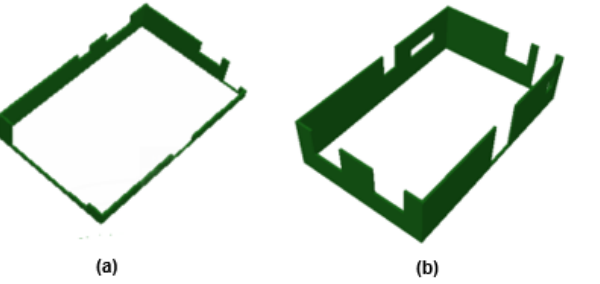
Figure 5. Activities status: ( a ) as-built BIM model of the first round of scan; ( b ) as-designed BIM model.